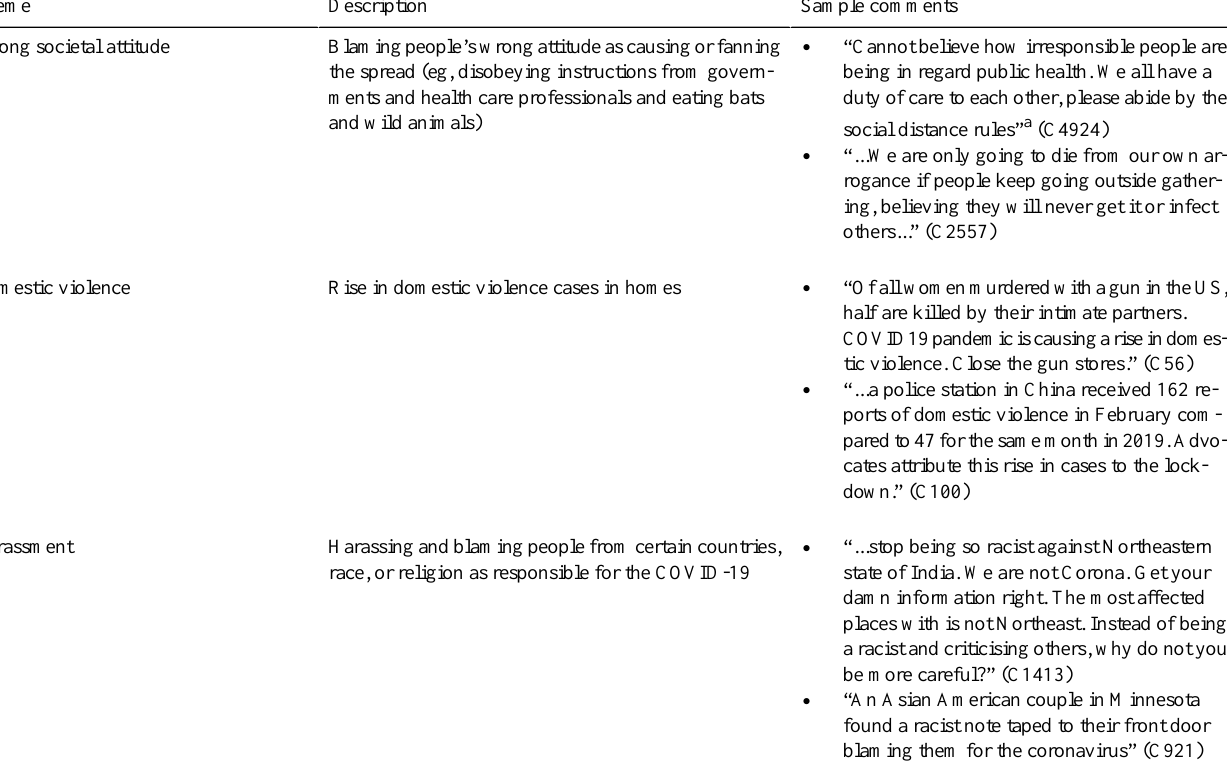
Table 4. Social issues: negative themes, descriptions, and corresponding sample comments.